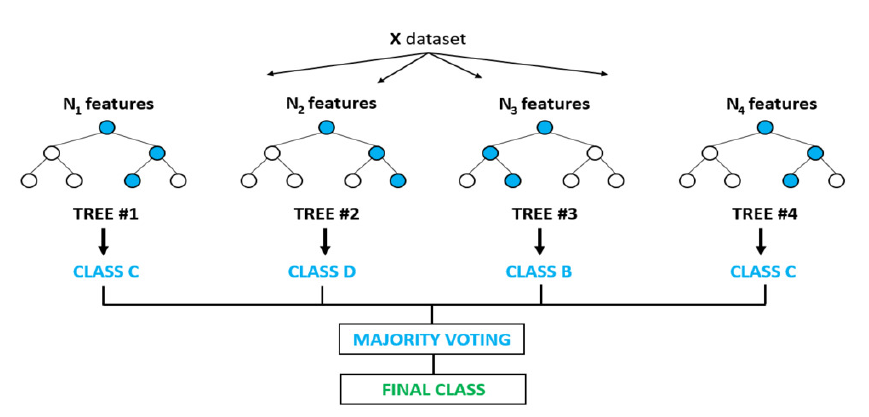
Figure 3. Ensemble method implemented by the Random Forest Algorithm. The ensemble consists of different trees fitted on the data with a range of hyperparameters. The tree which fits the data most optimally is then chosen by the algorithm by majority voting